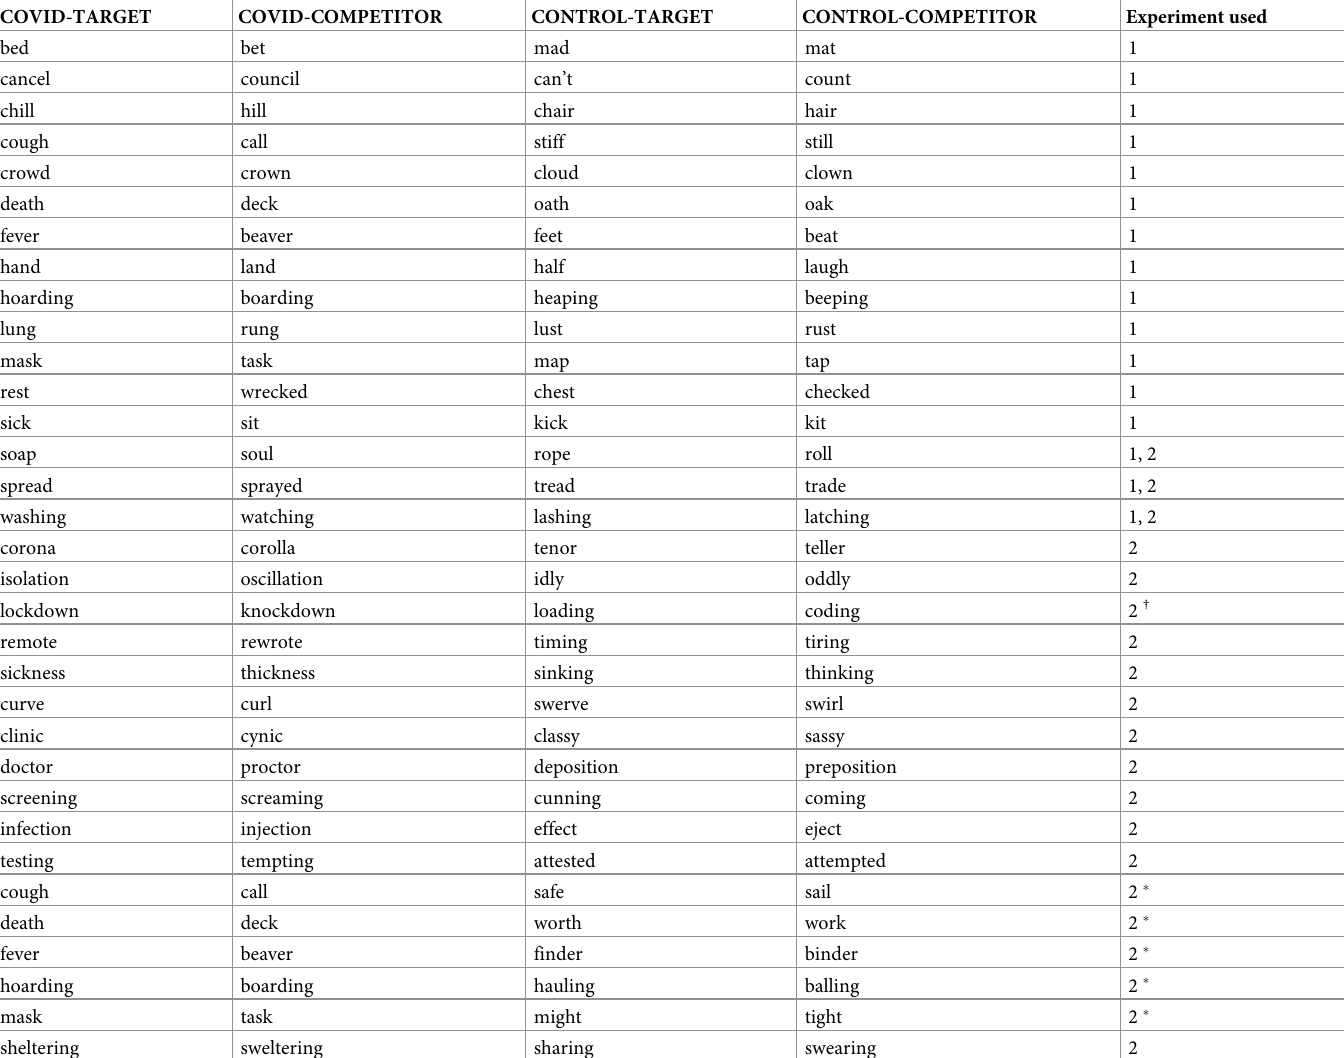
Table 1. List of stimuli used in experiments.